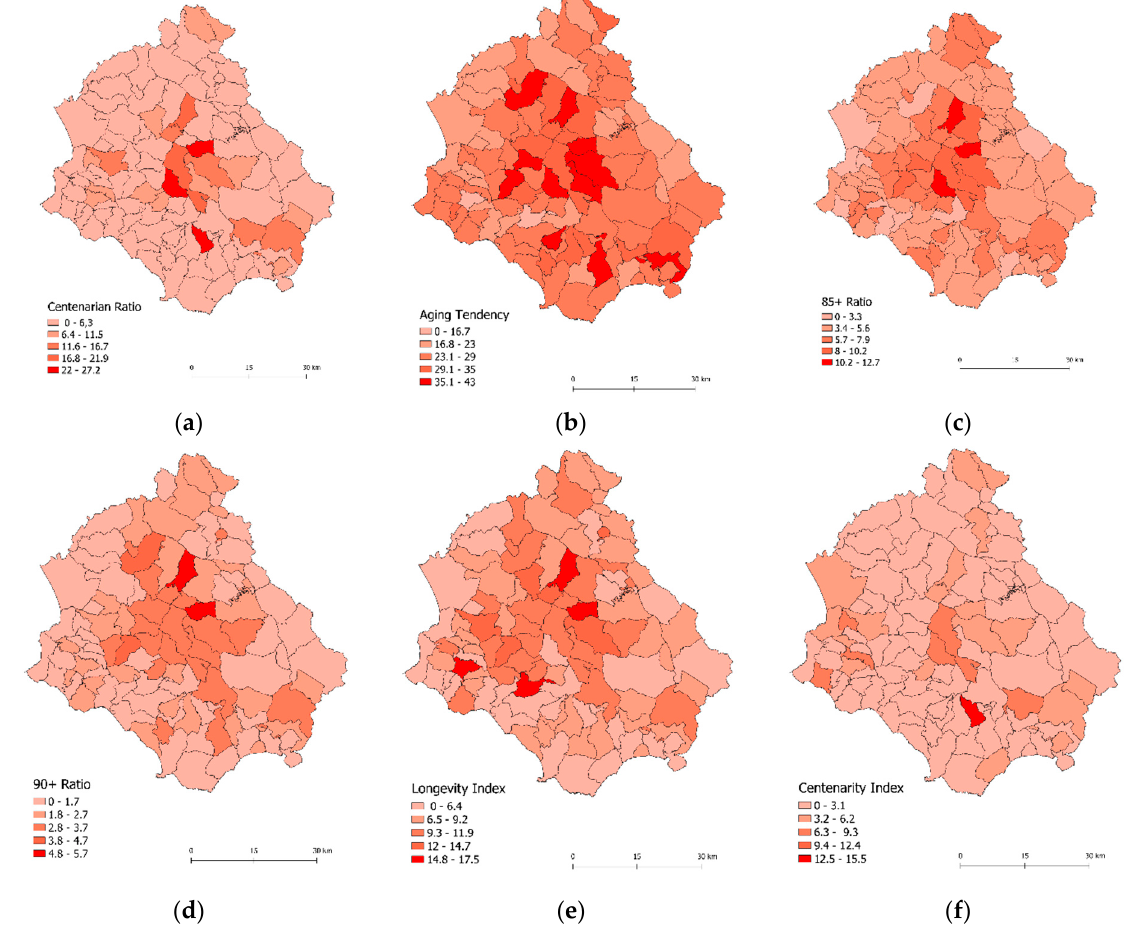
Figure 2. Spatial distribution of the six longevity indicators in Cilento. Note: ( a ) Spatial distribution of Centenarian ratio; ( b ) Spatial distribution of Aging tendency; ( c ) Spatial distribution of 85+ ratio; ( d ) Spatial distribution of 90+ ratio; ( e ) Spatial distribution of Longevity index; ( f ) Spatial distribution of Centenarity index.